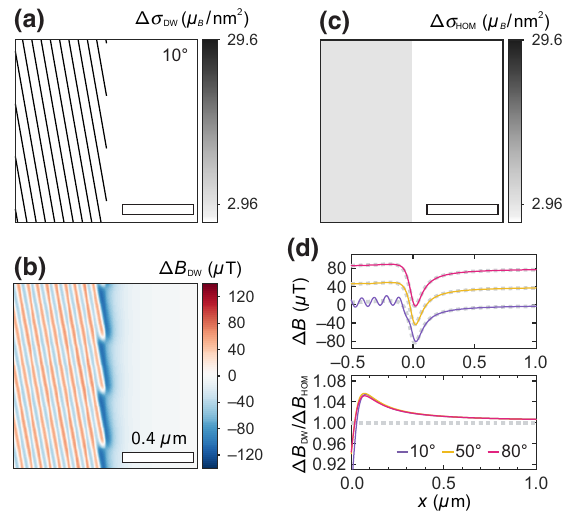
FIG. 16. (a) Spatial distribution of the magnetization change (cid:7)σ DW for DWDs of stripe domains. The domain walls form a 10 ◦ angle to the edge of the flake with spacing of 100 nm, and are assumed to move by 10 nm under an excitation field. (b) Sim- ulated stray field (cid:7) B DW along the NV center axis due to (cid:7)σ DW . (c) Spatial distribution of a homogeneous magnetization change (cid:7)σ (cid:7)σ hom , equivalent to spatial average of DW . (d) Top: line- cuts of the stray field (cid:7) B versus the distance x perpendicular to the flake’s edge. The field produced by three different angles for (cid:7)σ (cid:7)σ DW are shown as the solid lines and for hom as the dashed lines. The linecuts are offset for clarity and are Gaussian aver- aged in the y direction, parallel to the flake, over our optical beam size. Bottom: ratio of the stray field due to the particular domain wall distribution ( (cid:7) B DW ) to that produced by uniformly distributing the total magnetization change over area ( (cid:7) B hom ). The ratio approaches one as x increases, independent of the exact spatial distribution.